Question: What does this figure show? Answer in one sentence.
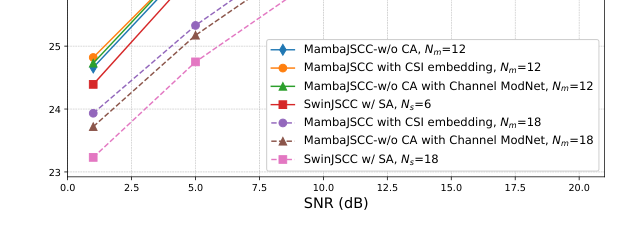
Answer: illustrates the performance of SwinJSCC w/ SA and MambaJSCC with different channel adaptation methods versus SNR under the AWGN and the Rayleigh fading channel. The Nm is set to 12 for the AWGN channel and 18 for the Rayleigh fading channel. Ns is set to 6. We can see that MambaJSCC with CSI embedding significantly outperforms SwinJSCC w/ SA across all SNRs in the both channels. For example, in the AWGN channel, a maximum gain of 0.43 dB is achieved at SNR=1 dB, and the minimum gain is 0.19 dB at SNR=20 dB. For the Rayleigh fading channel, the performance improvements at different SNRs are consistent, with an average gain of 0.65 dB. Moreover, the parameter size and the computational complexity of MambaJSCC with CSI embedding are significantly lower than those of SwinJSCC w/ SA. As shown in Table II, compared to SwinJSCC w/ SA with Ns = 6, MambaJSCC with CSI embedding requires 12.32 billion fewer MACs, 11.70 million fewer parameters for Nm = 12, and 7.39 billion fewer MACs and 6